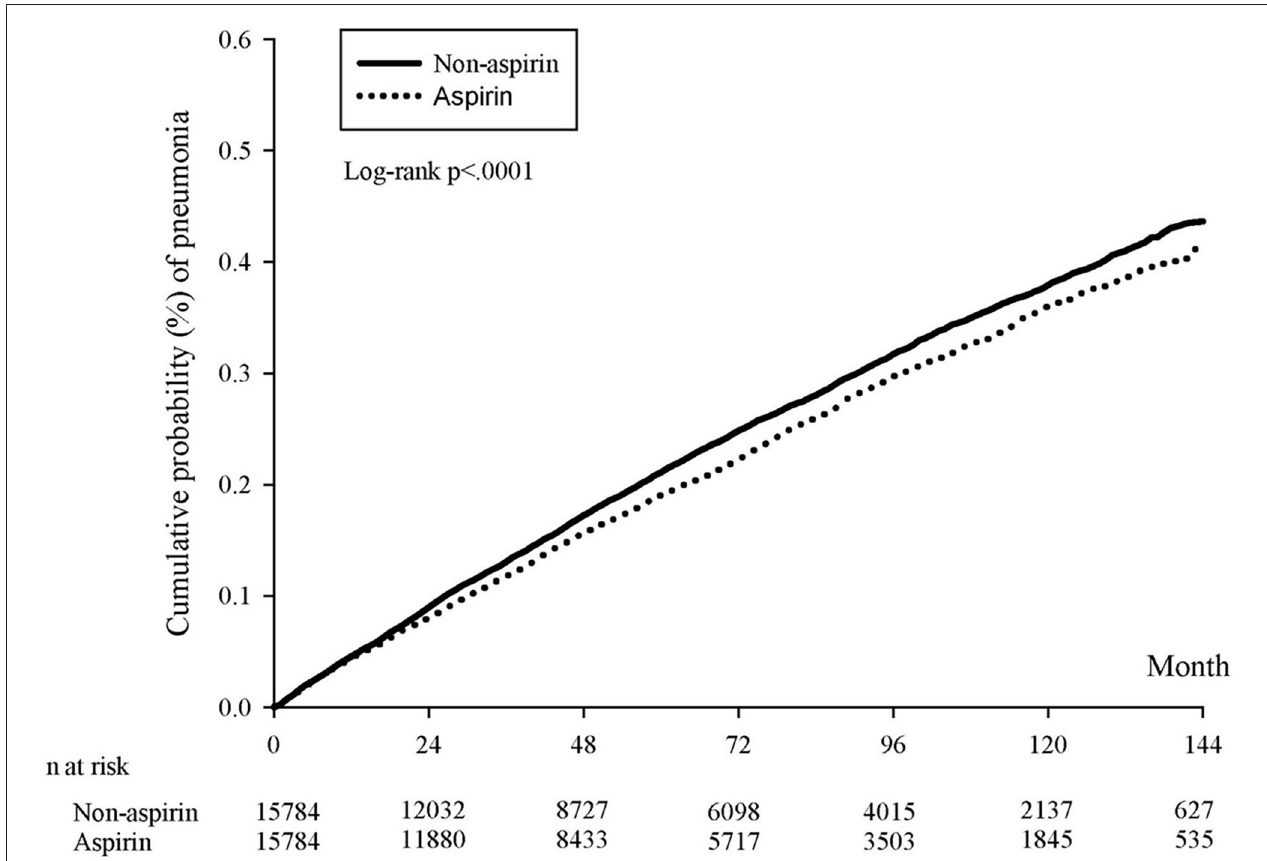
FIGURE 2 | Kaplan–Meier curves of the cumulative proportions of pneumonia after propensity score matching.